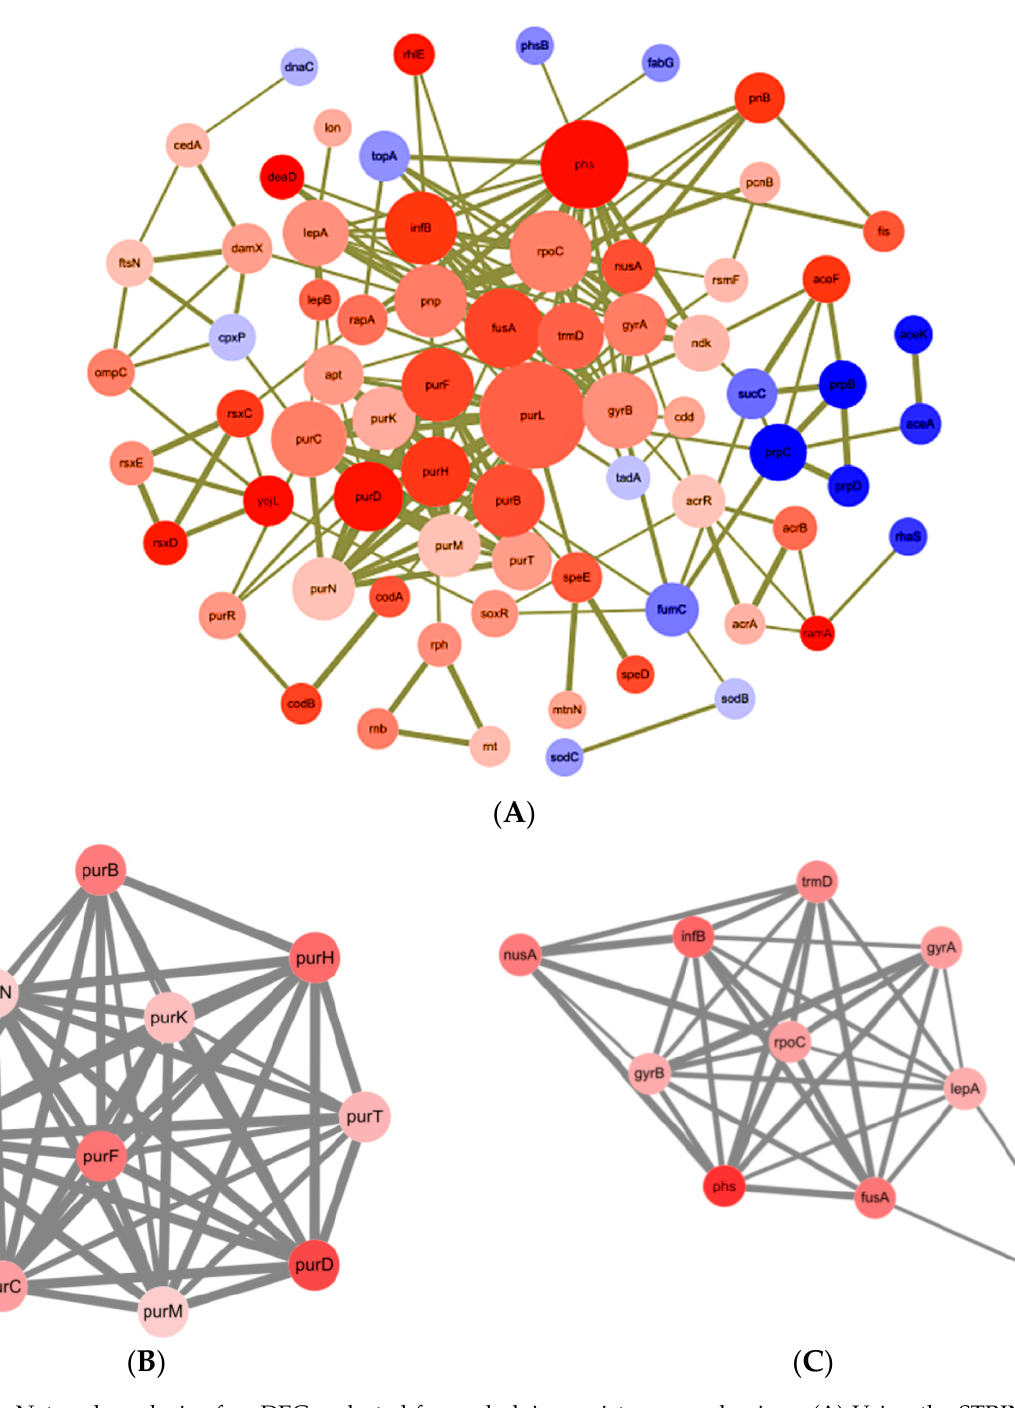
Table 2. Enrichment analysis of the top 2 MCODE genes function.